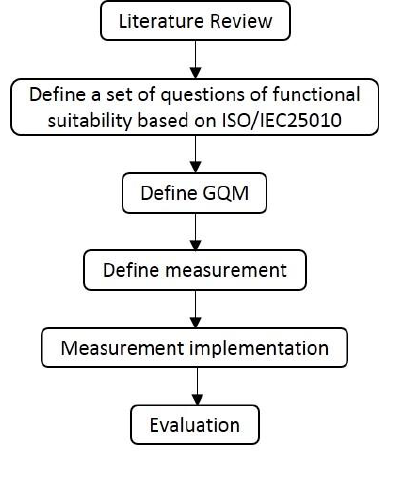
Fig. 1. Research Methodology T ABEL 1. MEASUREMENT